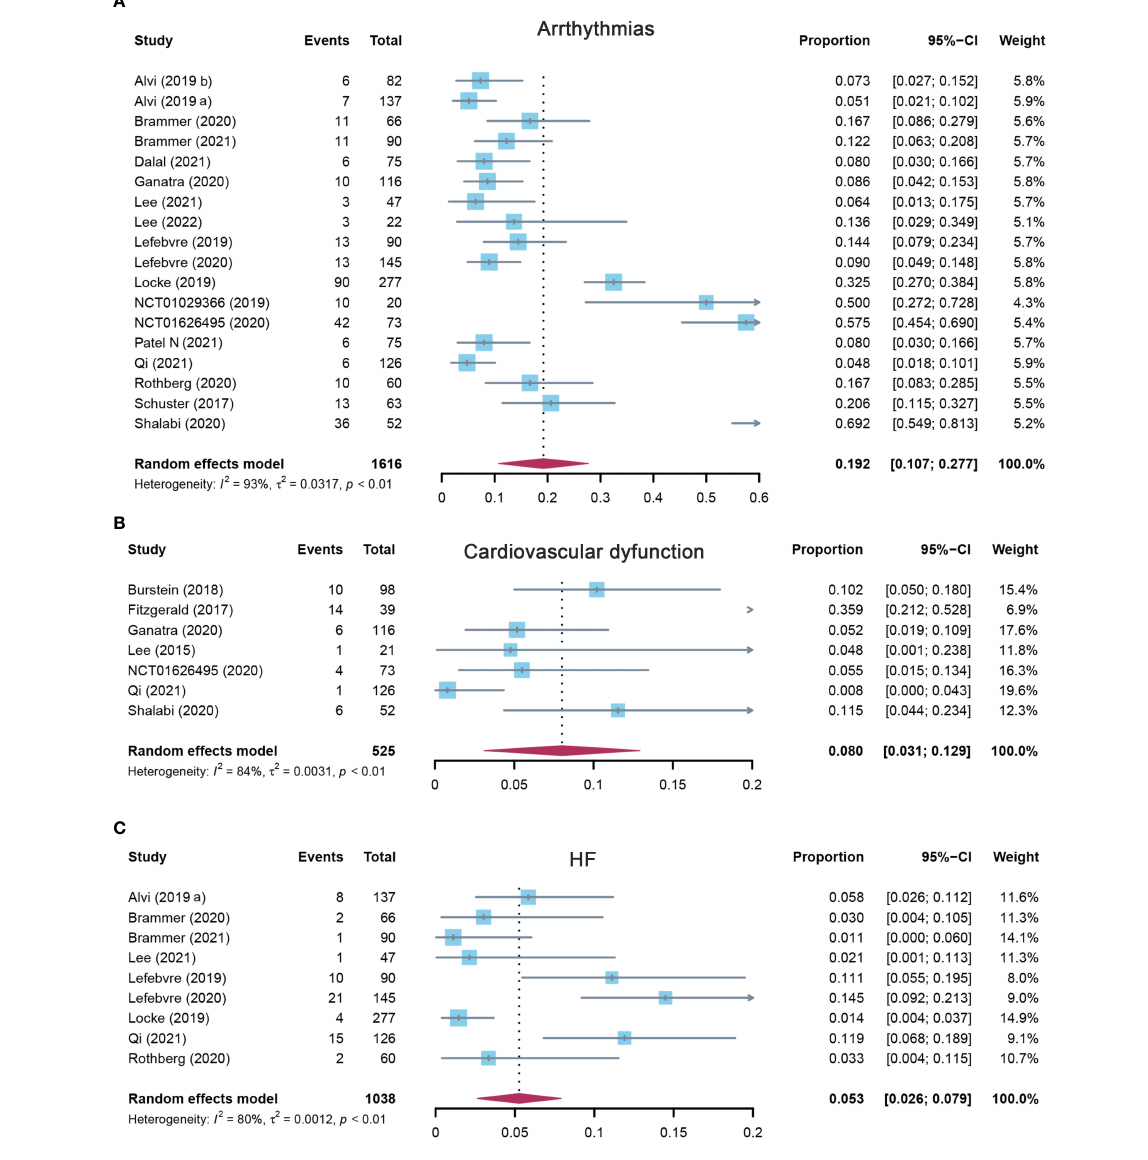
FIGURE 4 The forest plot of pooled incidence of (A) arrhythmias, (B) cardiovascular dysfunction, and (C) HF incidence rate in patients who received CAR-T cell therapy. HF, heart failure; CAR-T cell, chimeric antigen receptor T